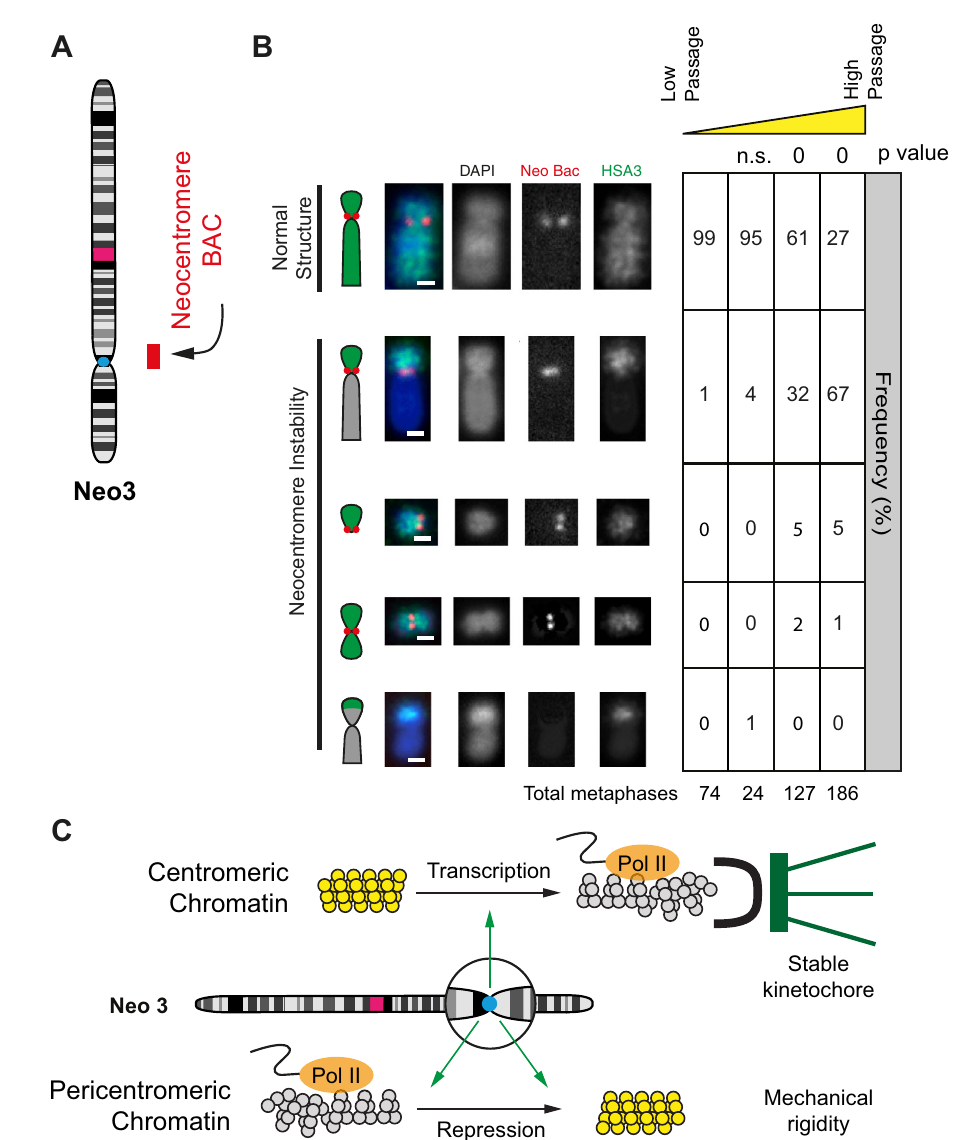
Fig. 7 | Neocentromere chromosome instability. A Neo3 ideogram and BAC probe used to analyse chromosome stability. B Left, representative 2D DNA FISH images of Neo3 metaphase chromosomes hybridised to a human chro- mosome 3 paint (green) and BAC (red) located at the neocentromere. Chro- mosome morphology was scored as normal or showing instability: deletions, fusions or duplications. The bar is 2 μ m. Right, quanti fi cation (%) of different chromosome morphologies with increasing passage number (low ~10, high